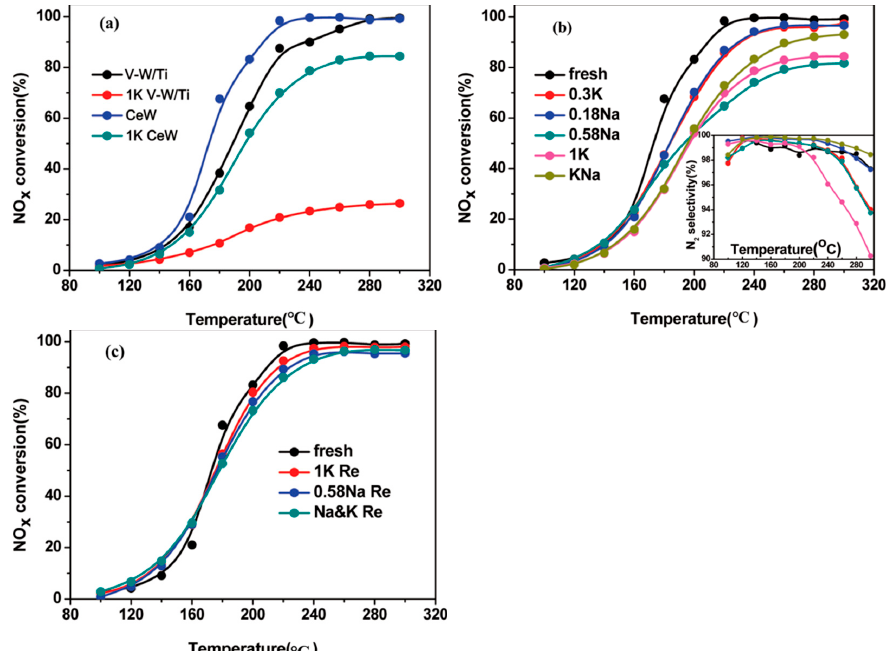
Figure 1. ( a ) Comparison of NH 3 − SCR activity of V − W/Ti and CeW catalysts with